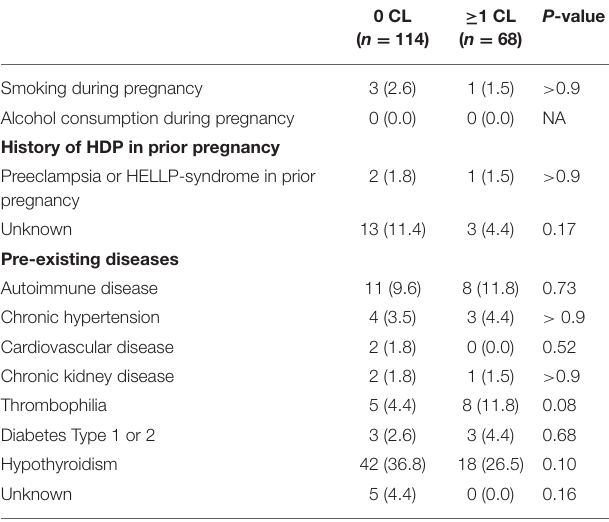
TABLE 1 | Baseline and medical history characteristics a